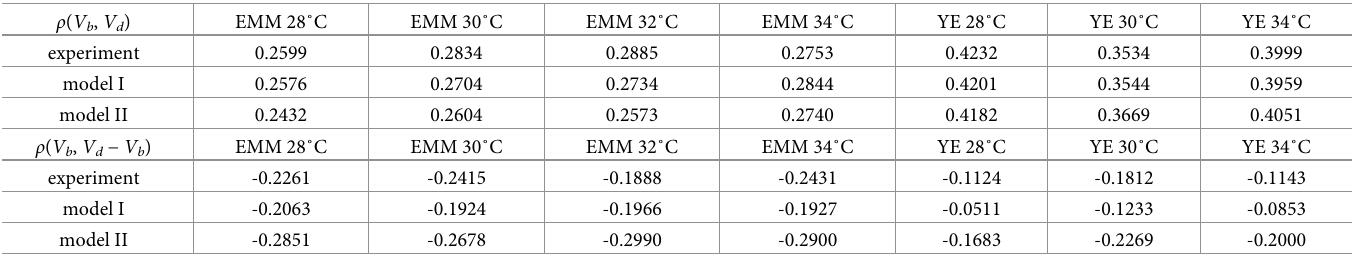
Table 3. Correlation coefficients between the birth and division (added) sizes for the seven growth conditions. The experimental correlation coefficients are computed using the lineage data, while the theoretical correlation coefficients are computed using stochastic simulations based on model I and model II. ρ ( V b , V d